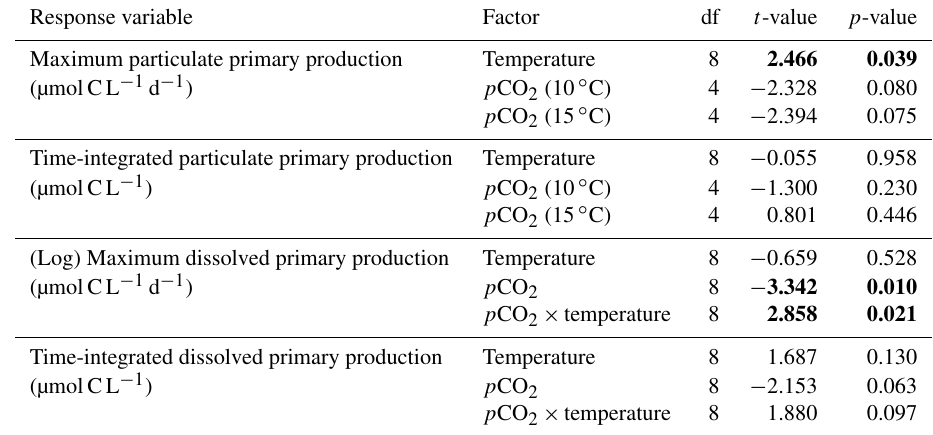
Table 5. Results of the generalized least squares models (gls) tests for the effects of temperature, p CO 2 , and their interaction. Separate analyses with p CO 2 as a continuous factor were performed when temperature had a significant effect. Maximum particulate and dissolved primary production, and time integration over the full duration of the experiment (day 0 to day 13). Natural logarithm transformation is indicated in parentheses when necessary; significant results are in